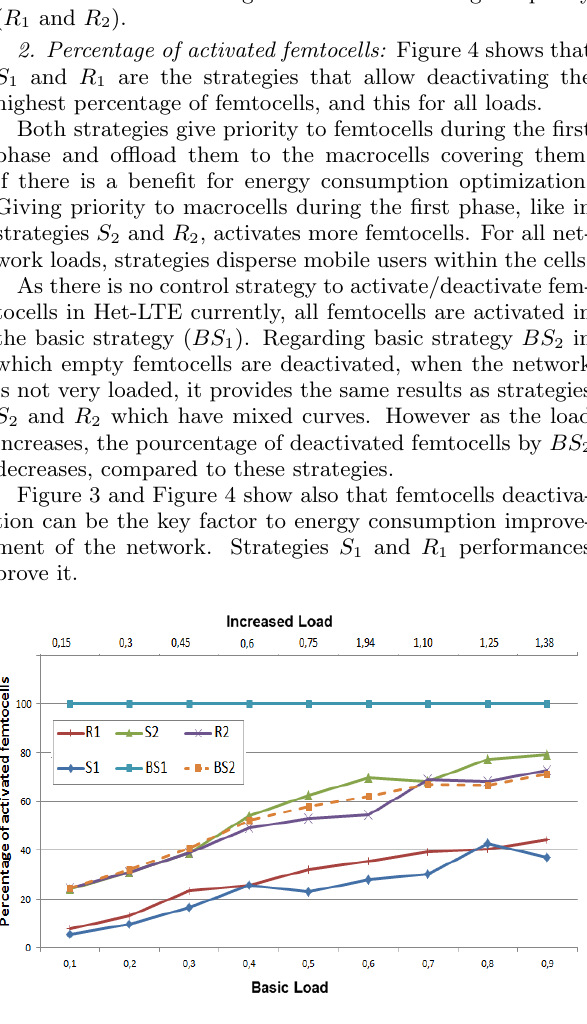
Figure 4: Percentage of activated femtocells.